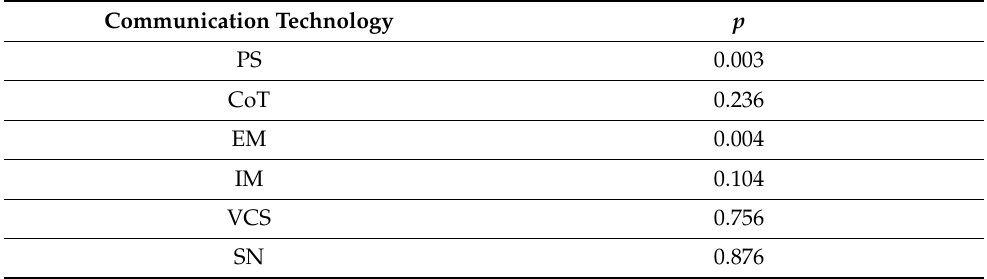
Table 9. Results of statistical inference t test to verify the independence of students’ and